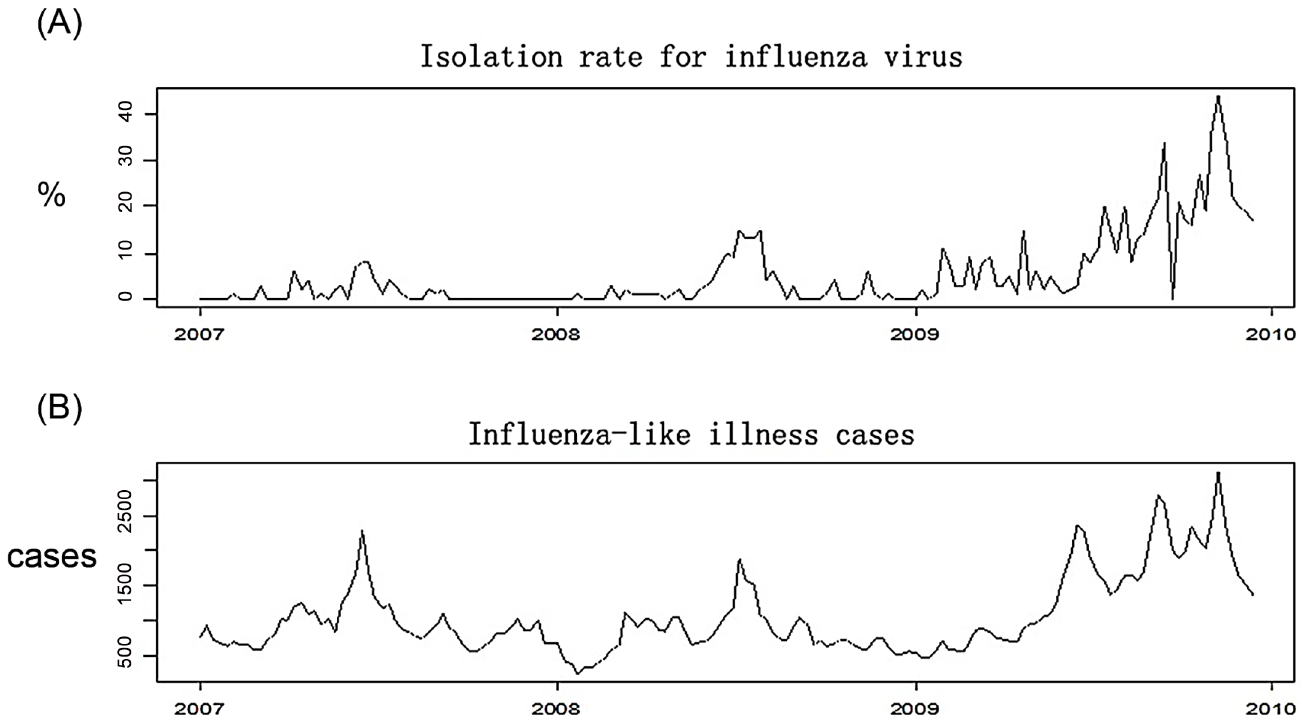
Fig 2. Seasonal pattern of influenza-like illness (ILI) and influenza by week, 2007 – 2009, Zhuhai City. Three years of ILI and influenza virus surveillance data were collected in Zhuhai City, Guangdong Province, China. A, the Y-axis shows the isolation rate (%) of influenza virus strains per week, which is the proportion of the number of influenza virus – positive specimens to the total number of specimens detected. B, the Y-axis shows the number of patients with ILI per